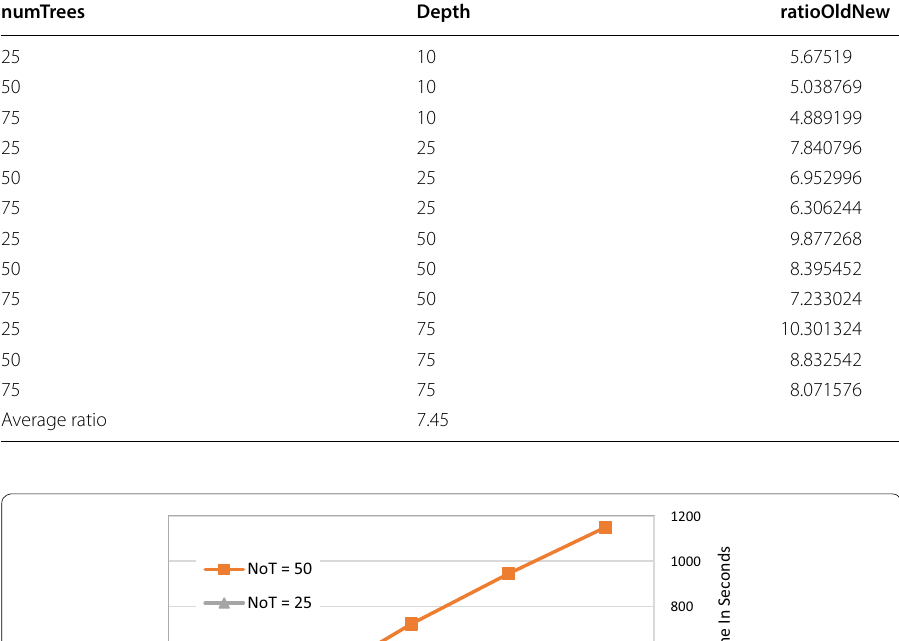
Table 2 SpeedUp ratio sorted by depth